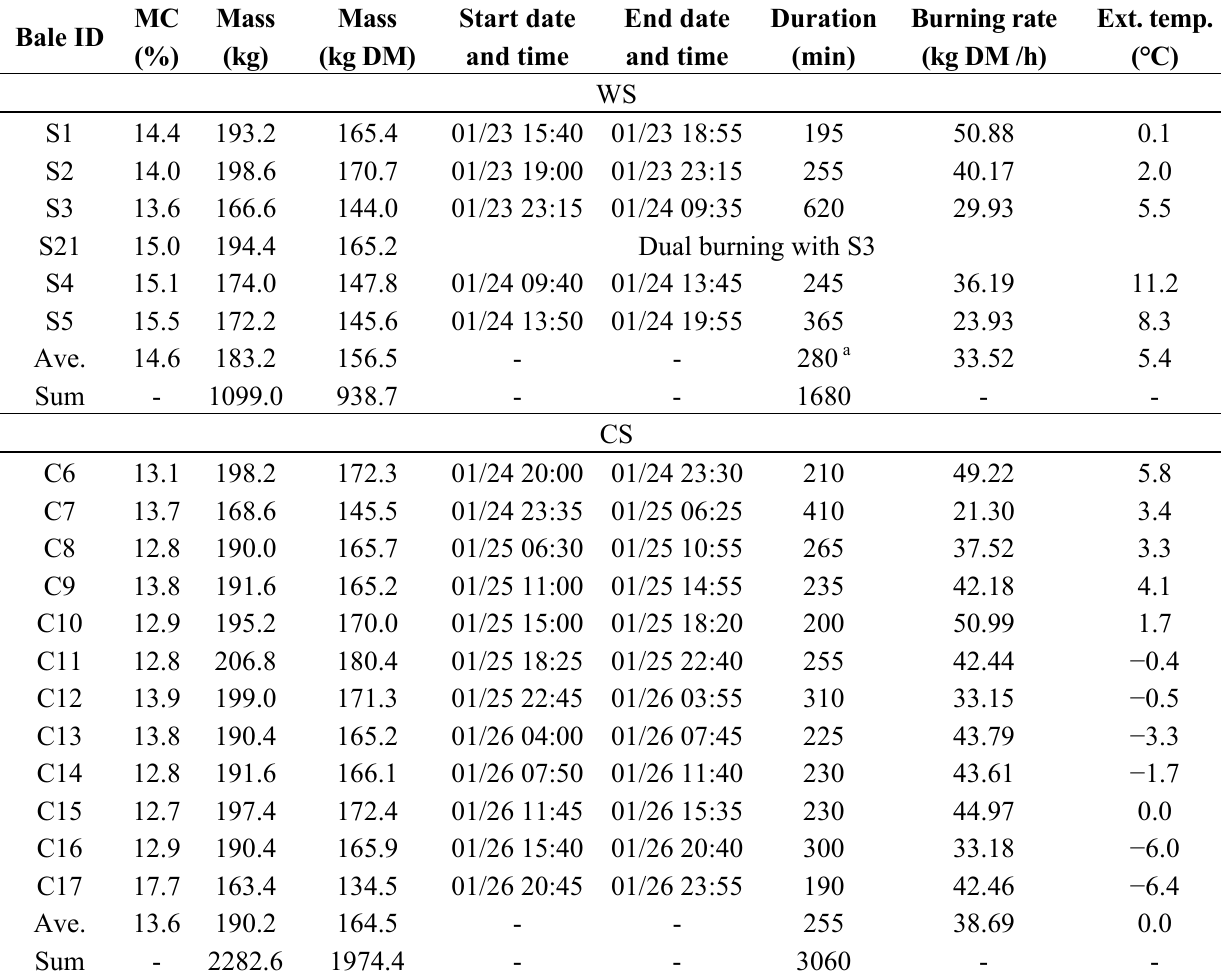
Table 2. Combustion trial loading sequence with burning duration and rate (2012 trials). Bale